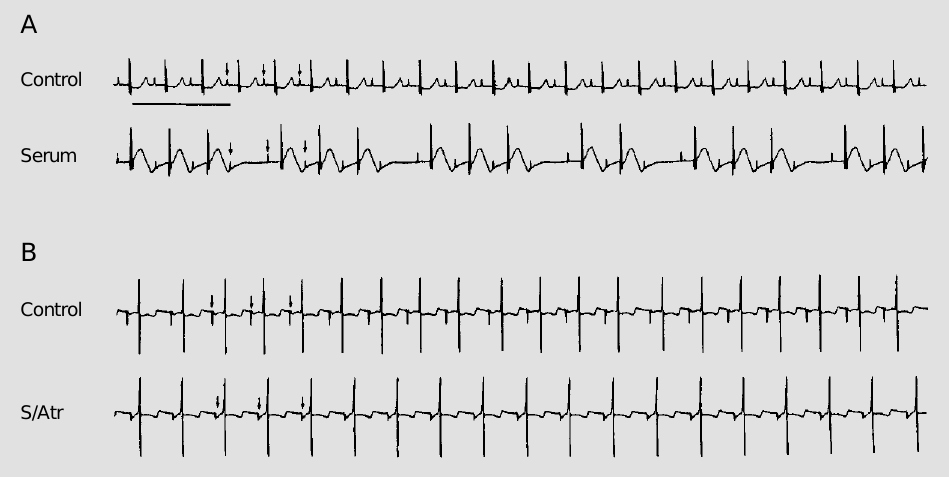
Figure 4 - Atrioventricular con- duction block (AVB) induced by serum from a chronic chagasic patient in the isolated rabbit heart. The arrows point to P waves. A , Control: during Tyrode perfusion; serum: ECG record- ing obtained in the presence of serum diluted 1:100 in Tyrode solution. Note the occurrence of AVB, characterized by several non-conducting P waves (not fol- lowed by the QRS complex). B , Control: recording obtained dur- ing atropine (1 µM) perfusion. S/ Atr: ECG recording obtained